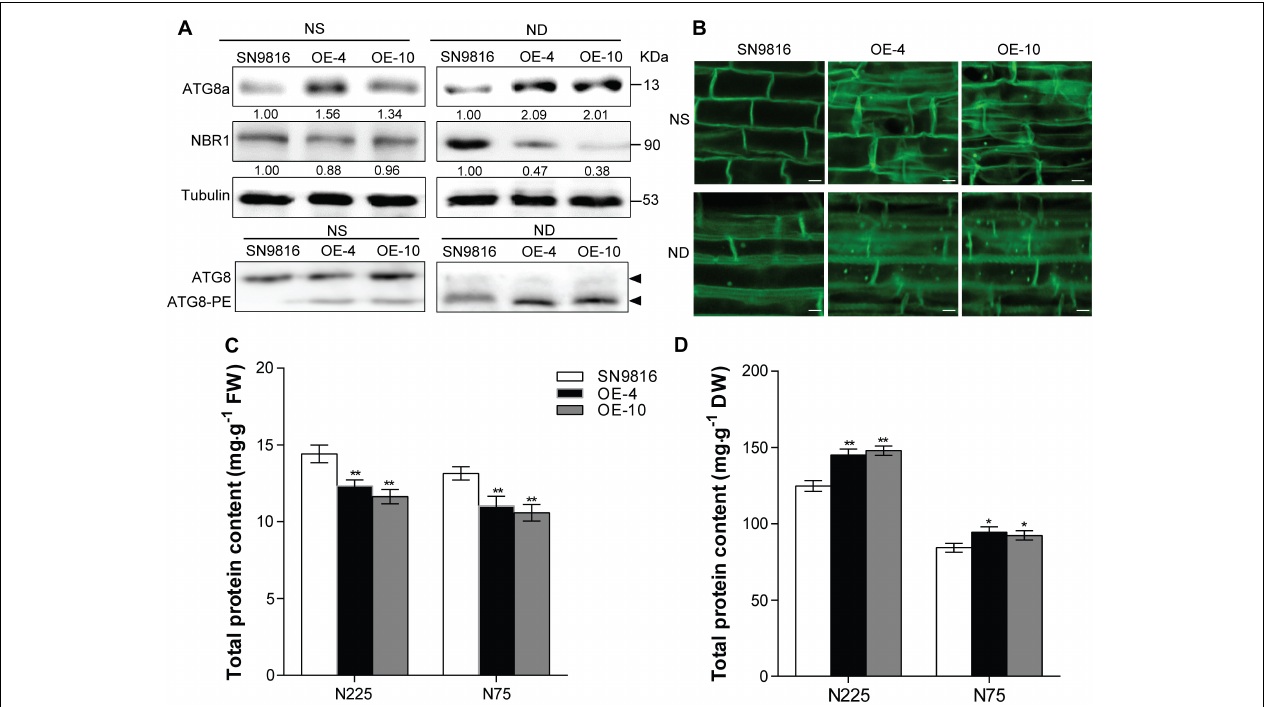
FIGURE 5 | Overexpression of OsATG8a enhances the autophagy levels in rice. 14-day-old seedlings of SN9816 and transgenic lines (OE-4 and OE-10) cultured hydroponically in NS (3.5 mM) solution were transferred to NS (3.5 mM) or ND (0 mM) solution for 24 h ( n = 10). (A) Immunoblot analysis of the extracts with anti- Arabidopsis ATG8a and NBR1 antibodies, near equal protein loads were confirmed by immunoblot analysis with an α -tubulin antibody. Numbers below the blot indicate intensity ratios between the NBR1 protein and the α -tubulin band in each line, and the intensity ratios in each line were normalized to SN9816 (value set to 1) under NS (3.5 mM) or ND (0 mM) conditions. The membrane fraction was used to detect the level of lipidated (ATG8-PE) and free ATG8 in the leaves. The ATG8-PE conjugates had a faster migration than ATG8 in the membrane fraction, so the band of ATG8-PE was below the band of ATG8 during SDS-PAGE in the presence of 6 M urea. (B) MDC-stained autophagosomes in roots were observed by confocal microscopy. Protein contents of leaves (at grain filling stage) (C) and seeds (after harvest) (D) extracts in SN9816 and transgenic lines (OE-4 and OE-10) under N225 and N75 conditions. The weight of each sample in (C) or (D) was the same, and the protein content was determined by BCA method as mg protein per gram fresh weight in leaves or mg protein per gram dry weight in seeds. Values are means ± SD ( n = 3), ∗ P < 0.05, ∗∗ P < 0.01 ( t